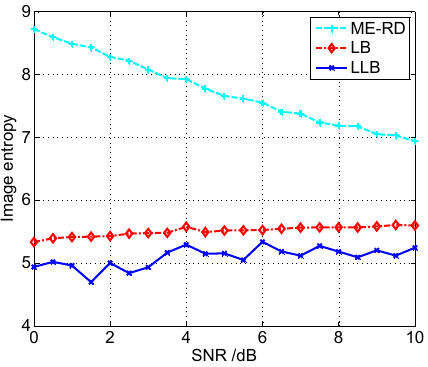
Figure 6. Comparison of image entropy curves versus SNR for different